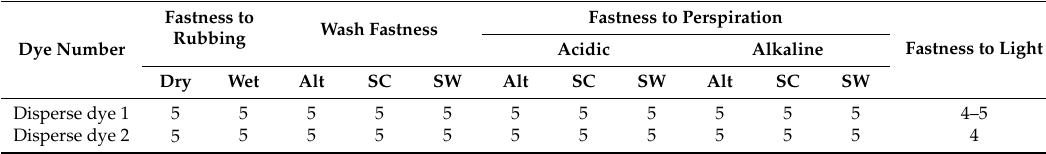
Table 3. Fastness properties of the polyethylene terephthalate fabrics dyed with disperse dyes 1 and 2 by utilizing a non-eco-friendly carrier.